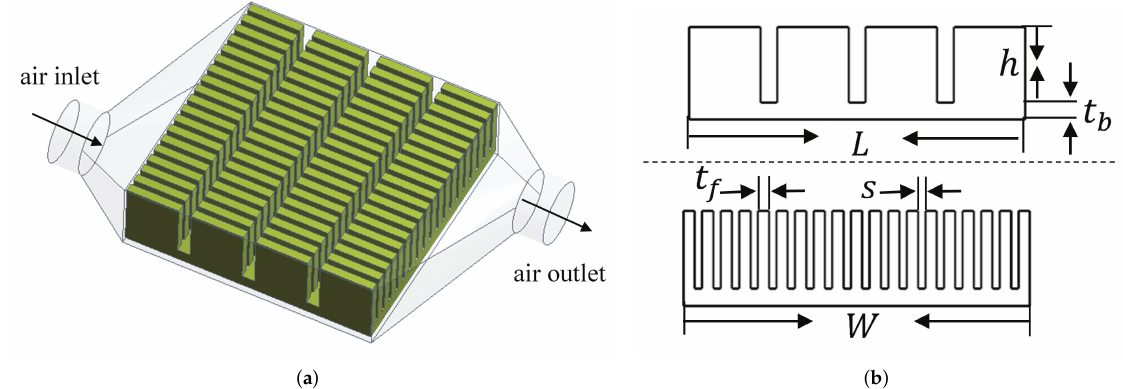
Figure 3. Simplified simulation model and schematic diagram of heat-sink parameters: ( a ) simulation model with a cold-side heat sink and a ceramic substrate; ( b ) schematic diagram of heat-sink structural parameters W , L , h , t b , t f and s